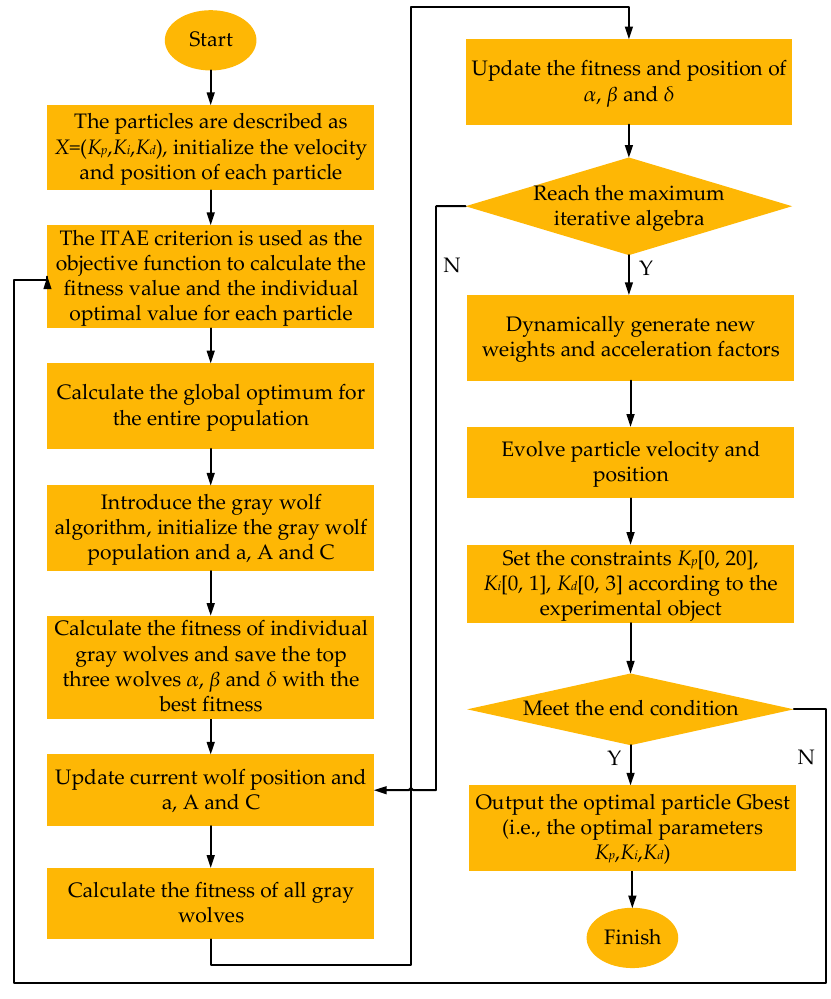
Figure 3. GWOPSO algorithm flow chart.